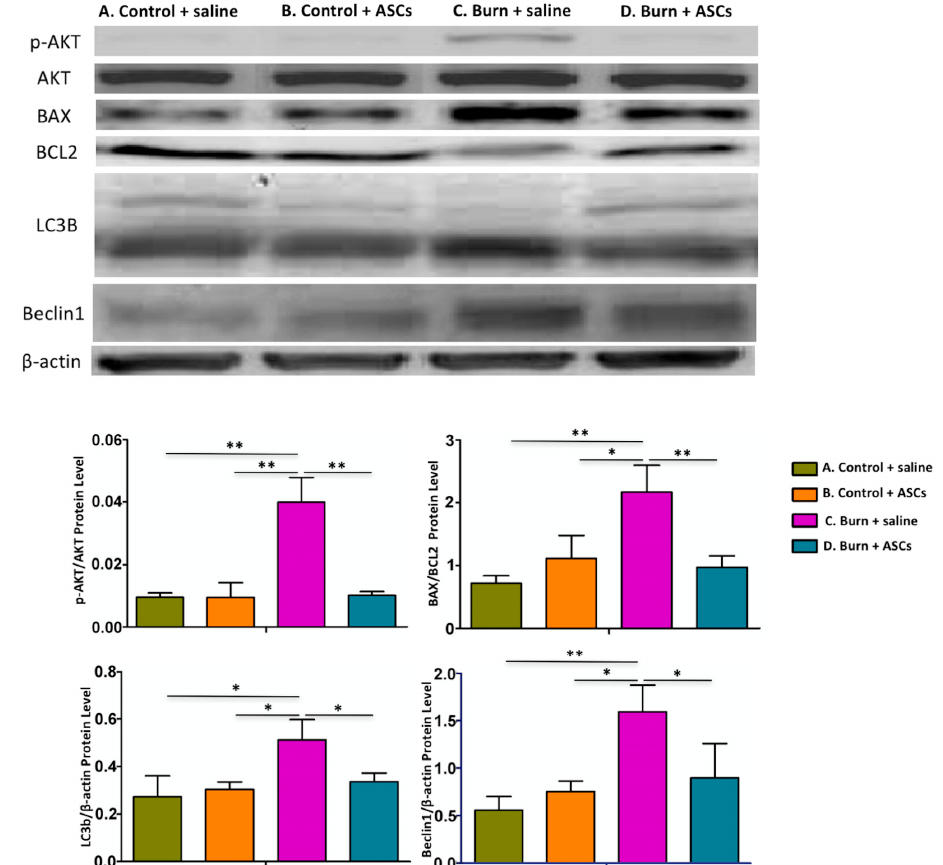
Figure 7. Decreased and apoptosis and autophagy in the spinal cord after ASC transplantation. Four weeks after subcutaneous ASC transplantation or saline injection into burn-injured skin, western blot analyses of dorsal horn specimens revealed significantly increased ratios of p-Akt/Akt and Bax/Bcl-2 and levels of LC3B-II and Beclin 1 in Group C compared to Groups A, B and D. This suggests that the apoptosis and autophagy promoted in the spinal cord were attenuated after ASC transplantation. Data are presented as means ± standard errors of the means. (** p < 0.01, * p < 0.05).